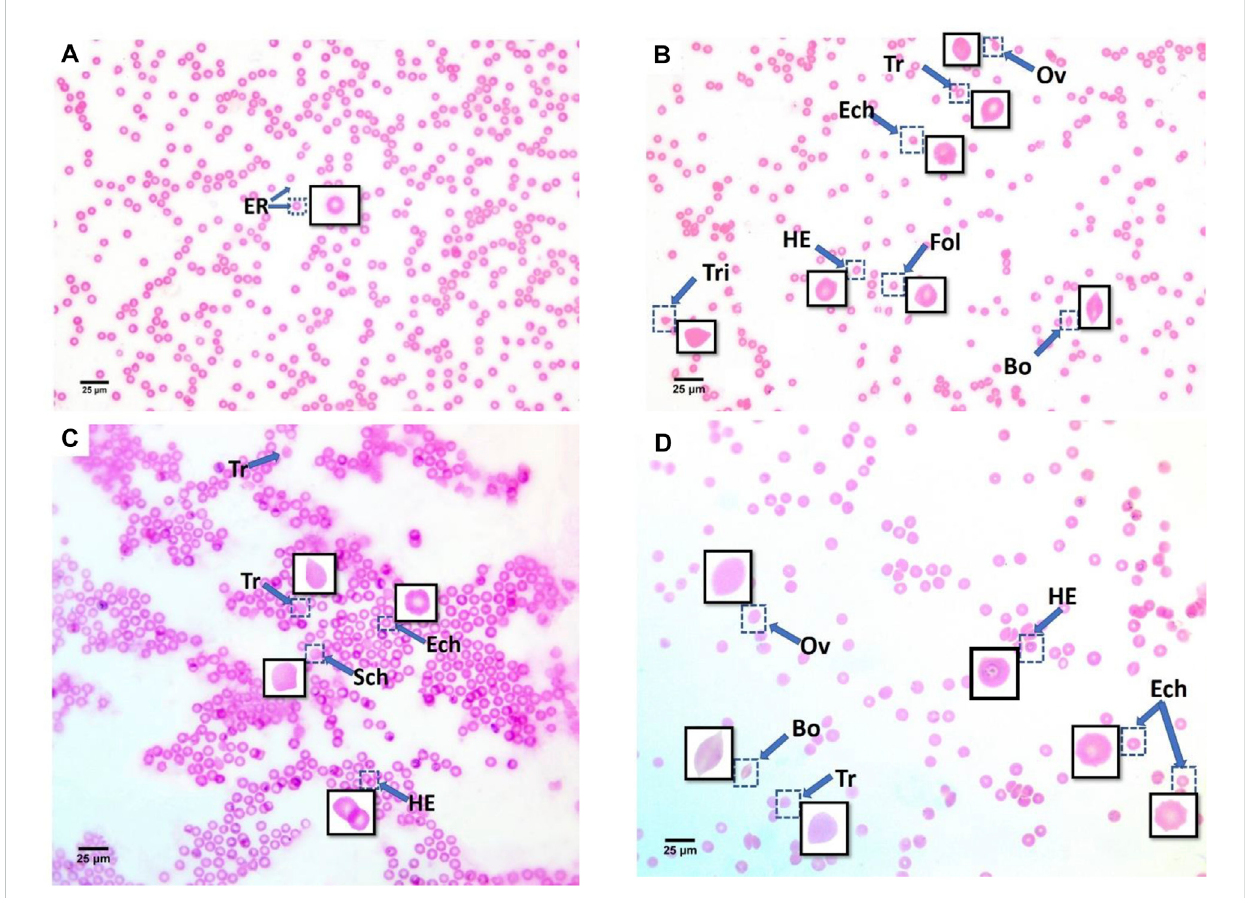
Blood smears ofrecovery micegroups withpolyethylenemicroplastics: (A) control, (B) 6 μ g/mlMPs, (C) 60 μ g/mlMPs, and (D) 600 μ g/mlMPs. ER: erythrocytes; Tr: teardrop-like cells; HE: helmet cell; Sic: sickle cells; Sch: schistocytes; fol: folded cells; Bo: boat-shaped cell; Ov: ovalocytes; Ech: echinocytes; and Tri: triangular cells (H&E